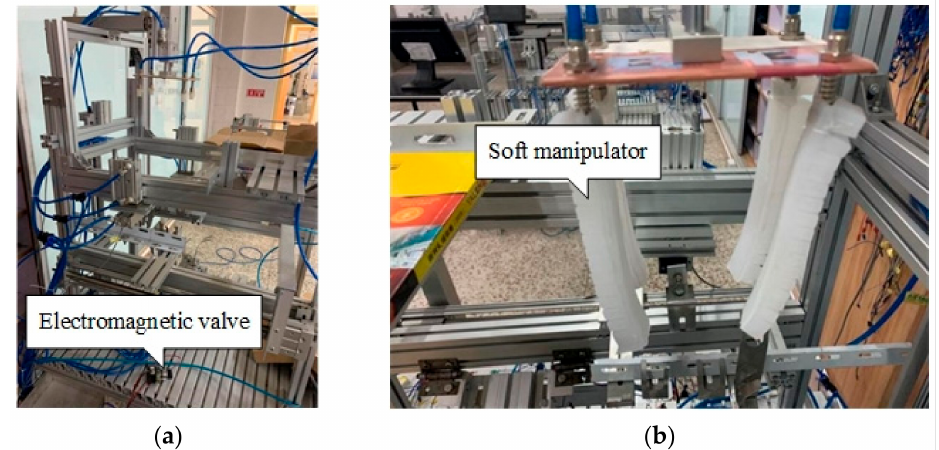
Figure 11. ( a ) Experimental platform; ( b ) assembled soft